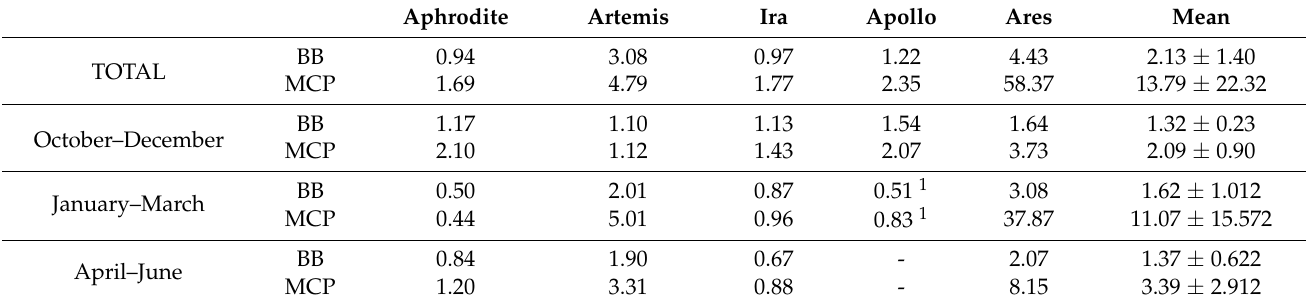
Table 2. Home range size (in km 2 ) of wildcats estimated using the 95% Brownian Bridge (BB) and 95% Minimum Convex Polygon (MCP) home range estimators. Estimates are presented for the total study period and per calendar trimester.